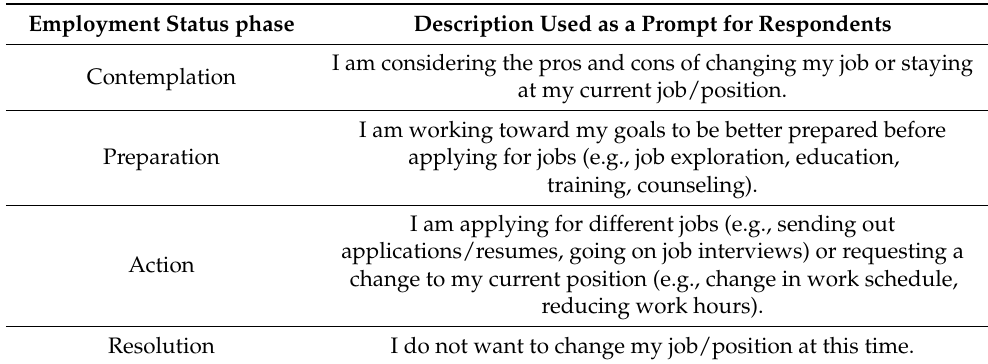
Table 6. Employment Decision-Making Scale-Employed-Revised